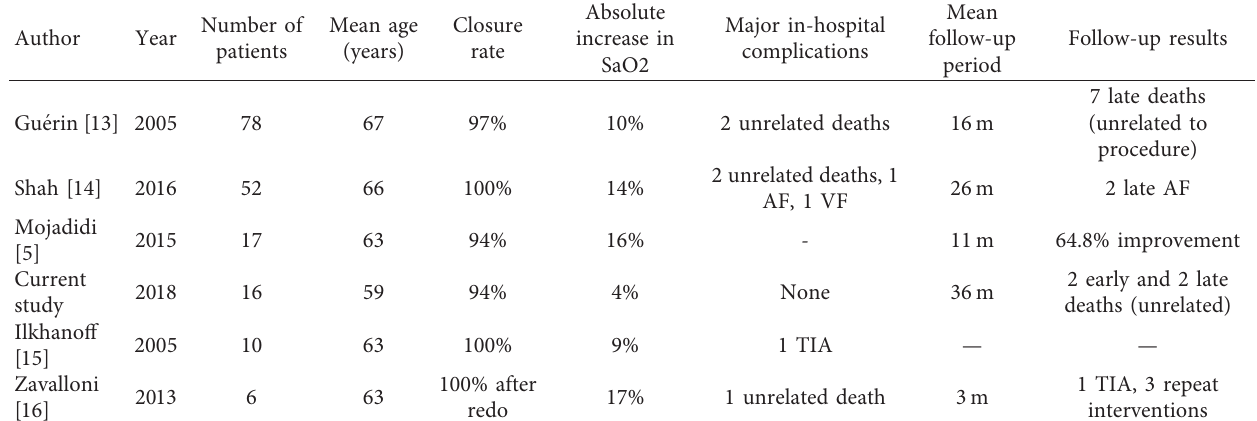
Table 5: Published series of PFO closure because of dyspnea or